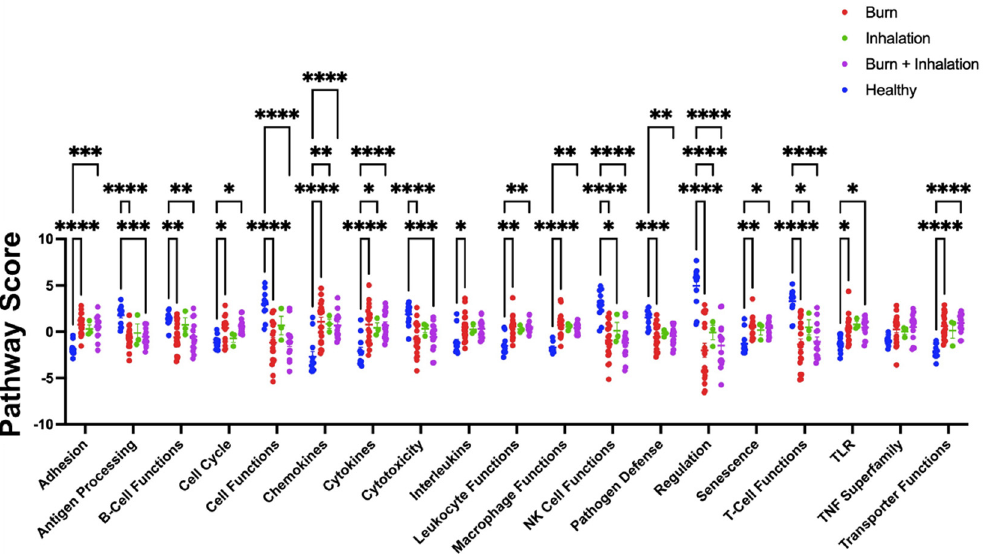
Figure 5. Gene expression changes following burn injury alone, inhalation injury alone, and com- bined BI injury result in significant different pathway scores within immunometabolic pathways. mRNA was isolated from PBMC, which was isolated from burn patients or healthy controls, and gene expression was evaluated using nanostring barcoding (nCounter Human Immune Profiling PanCancer CodeSet; 770 genes, and the Human Metabolic Gene CodeSet; 768 genes). Pathway scores (PS) from principal component analysis (PCA) of the gene expression data were generated utilizing nSolver v4.0 and R. One-way ANOVA with Bonferroni’s multiple comparisons was used to determine significance. Data shown ± SEM; * p < 0.05, ** p < 0.01, ***, p < 0.005, ****, p <